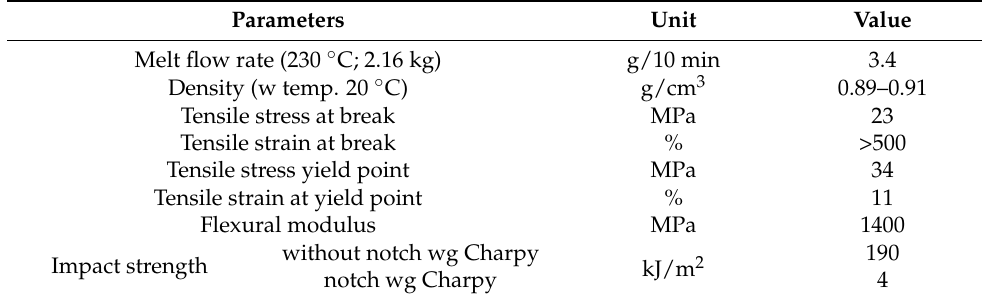
Figure 2. Examples of composite tiles with wood chips Lignocel 3-4 (PP/Lignocel 3-4). Table 1. Characteristics of the material matrix (polypropylene PP Moplen HP456J) [17].